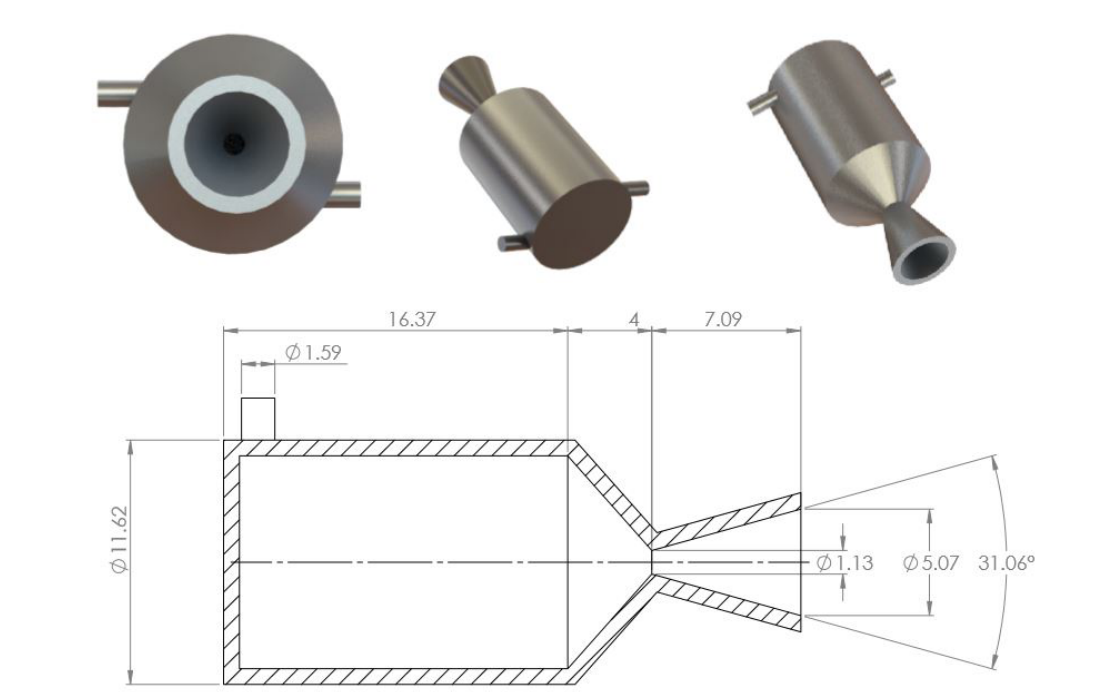
Figure 8. Schematic of the 1.25 N primary driver thruster. Dimensions are in